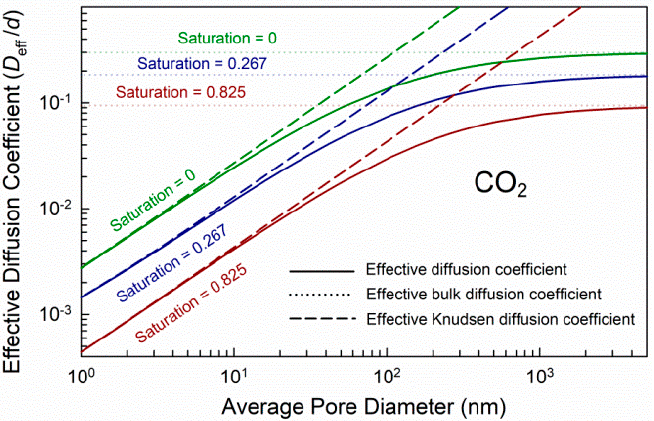
Figure 8. Changes of effective diffusion coefficient D eff / d (solid line) of carbon dioxide under three saturations (0.825, 0.267 and 0) with mean pore diameter, compared with those of effective bulk diffusion coefficient D b / d (dotted) and effective Knudsen diffusion coefficient D kn / d (short dash). The dark green, dark blue and dark red colors represent the saturation of 0, 0.267 and 0.825, respectively.